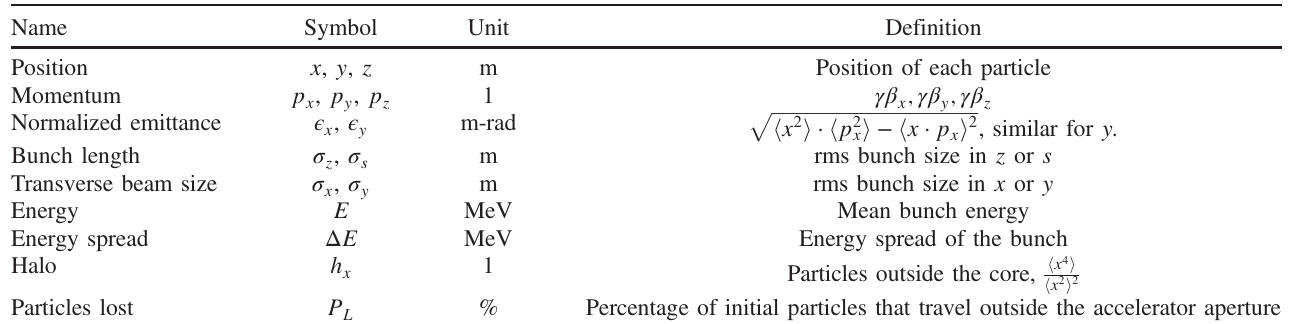
TABLE II. Definitions of beam parameters referred to in the